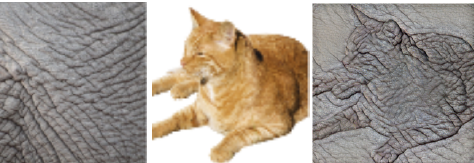
Figure 3. Texture–shape cue conflict [24]: texture ( left ) is classified as elephant; content ( middle ) is classified as cat; texture–shape ( right ) is classified as elephant because of a texture bias.